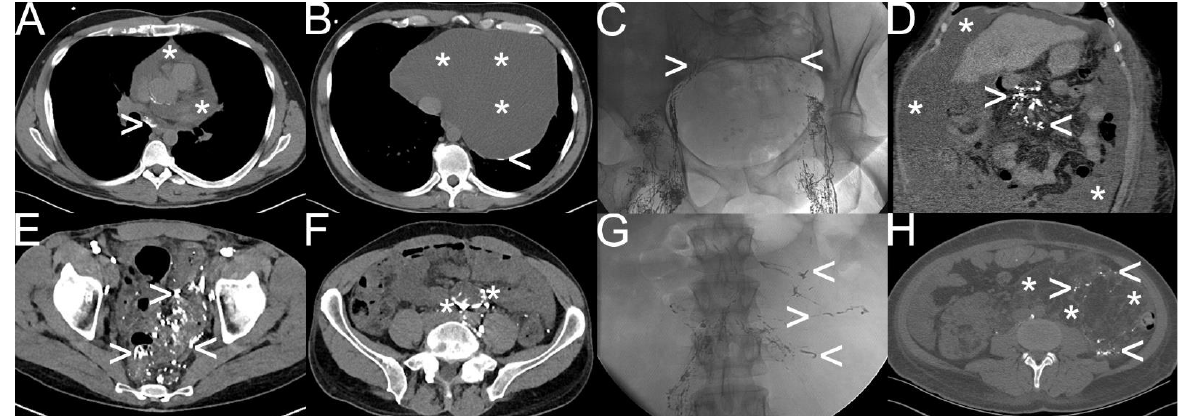
Figure 3. “ ׅׅ Transpedal lymphangiography“— How it is performed. Note: ( A ) Patent Blue test; ( B ) sterile, cut-down of the dorsum of the foot; ( C ) selective dissection of a lymph duct; ( D ) selective puncture of the lymph duct with a 25 G baby cannula; ( E , F ) injection of the oil-containing contrast material; ( G , H , I ) confirmation of the regular distribution of the oil-containing contrast material (white arrowhead) in the central lymphatic system (corresponding to a regular lymphatic run-off).